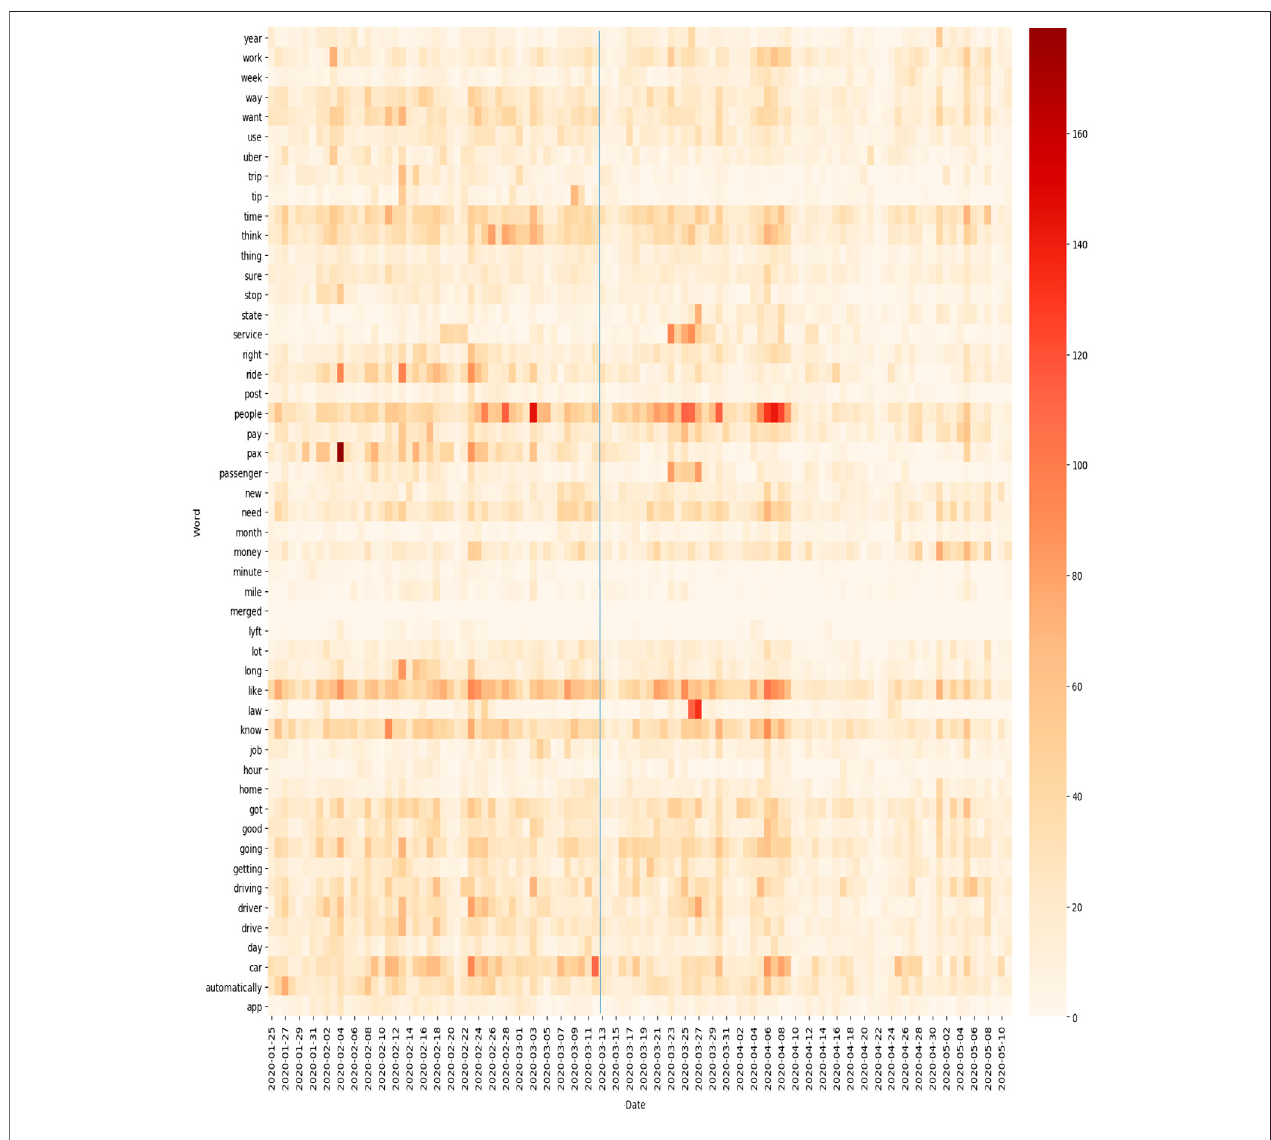
FIGURE 3 | Heatmap of Uber Advice